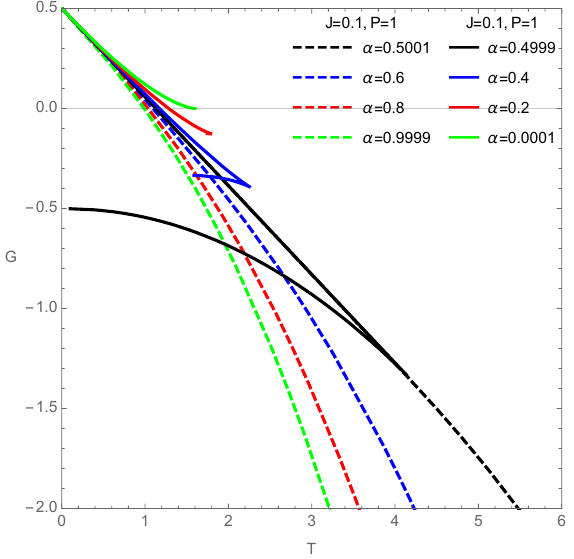
Figure 8 . Gibbs free energy at the transition between majority standard ( (cid:11) > 0 : 5; (cid:13) < 0 : 5)